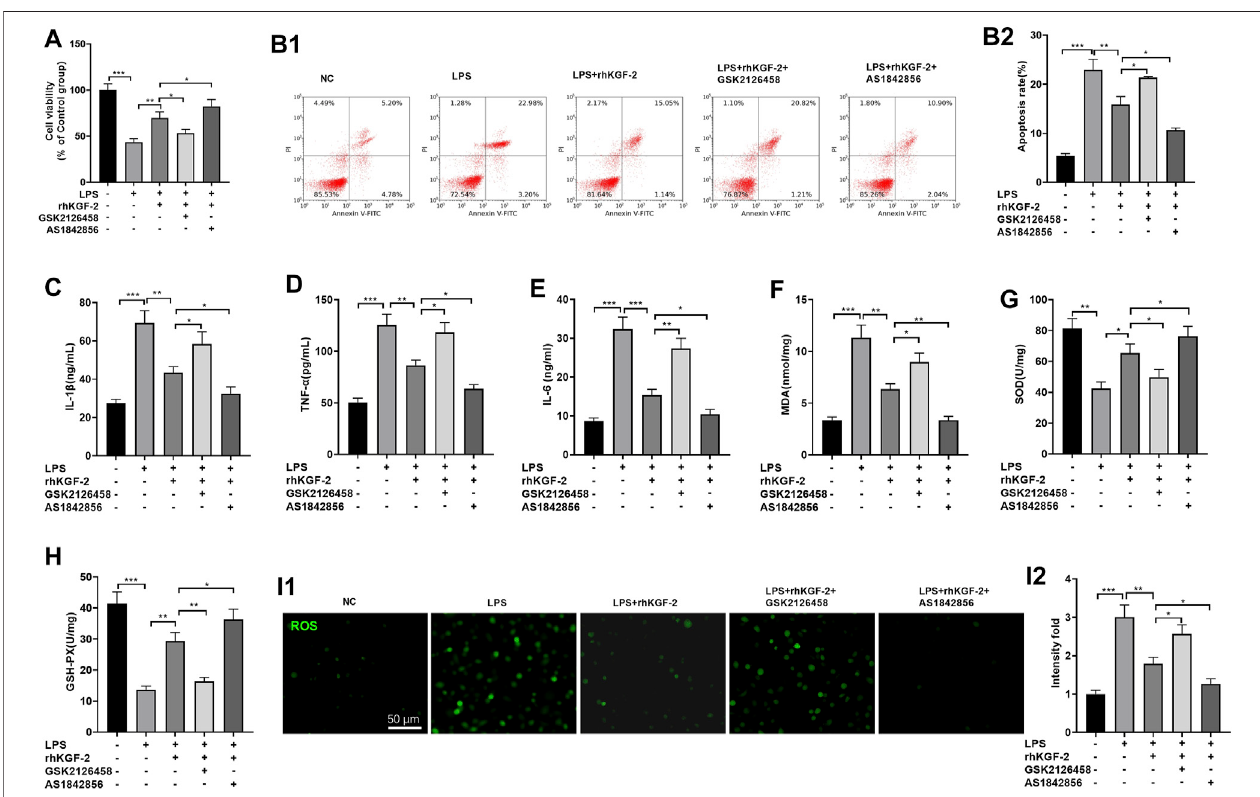
FIGURE3| TheeffectofPI3KinhibitorandFoxO1inhibitoronrhKGF-2-mediatedeffectonHPAEpiCcells.LPS-treatedHPAEpiCcellswereadoptedtoconstructa lung cell injury model, and then rhKGF-2 (10 ng/ml), GSK2126458 (0.5 nM) and AS1842856 (30 nM) were added for treatment for 24 h. (A) : MTT assay was implemented to verify HPAEpiC viability. The cell viability was calculated as the relative fold change of control group. B1-B2 . Flow cytometry was performed to verify HPAEpiCapoptosis.Therateofcellintherightupperquadrantwascountedasapoptoticcells. C – H :ELISAwasconductedtodetecttheexpressionofTNF- α (C) , IL-1 β (D) , IL-6 (E) , MDA (F) , SOD (G) , and GSH-PX. (H) . The Y -axis shows the content of the detected mediators. (I) . The cellular ROS level was detected using the DCFDA/H2DCFDA-Cellular ROS Assay kit. The X -axis indicates the relative fl uorescence intensity of ROS of NC group. Data are expressed as mean ± SD. All experiments were repeated for three times. Data difference was analyzed via ANOVA, and Student ’ s t test. * p ＜ 0.05, ** p ＜ 0.01, *** p ＜ 0.001. N (cid:2)